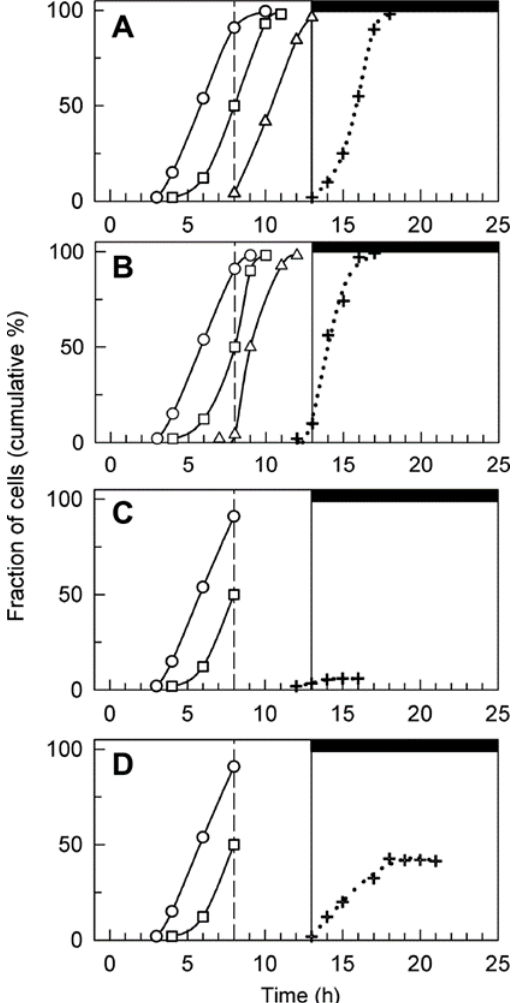
Figure 4. Cell cycle progression of untreated ( A ), ca ff eine-treated ( B ), zeocin-treated ( C ) and ca ff eine / zeocin-treated ( D ) synchronized populations of C. reinhardtii cells. The graphs show the percentages of cells that attained CP (empty symbols, solid lines) for division into two (circles), four (squares), and eight (triangles) cells, and completed cell division (crosses, dotted line). For ca ff eine / zeocin treated cultures, the extent of attempted aberrant division is plotted. The addition of ca ff eine and zeocin at the eighth hour of the cell cycle is marked by the dashed line, light and dark periods are indicated by stripes above the panel and by the vertical solid line. Means from at least four independent experiments are presented; the standard errors did not exceed 5% and are hidden within the symbols. Cell division was accelerated in the presence of ca ff eine and blocked in the presence of zeocin; about forty percent of the cells attempted an aberrant division in the presence of ca ff eine /